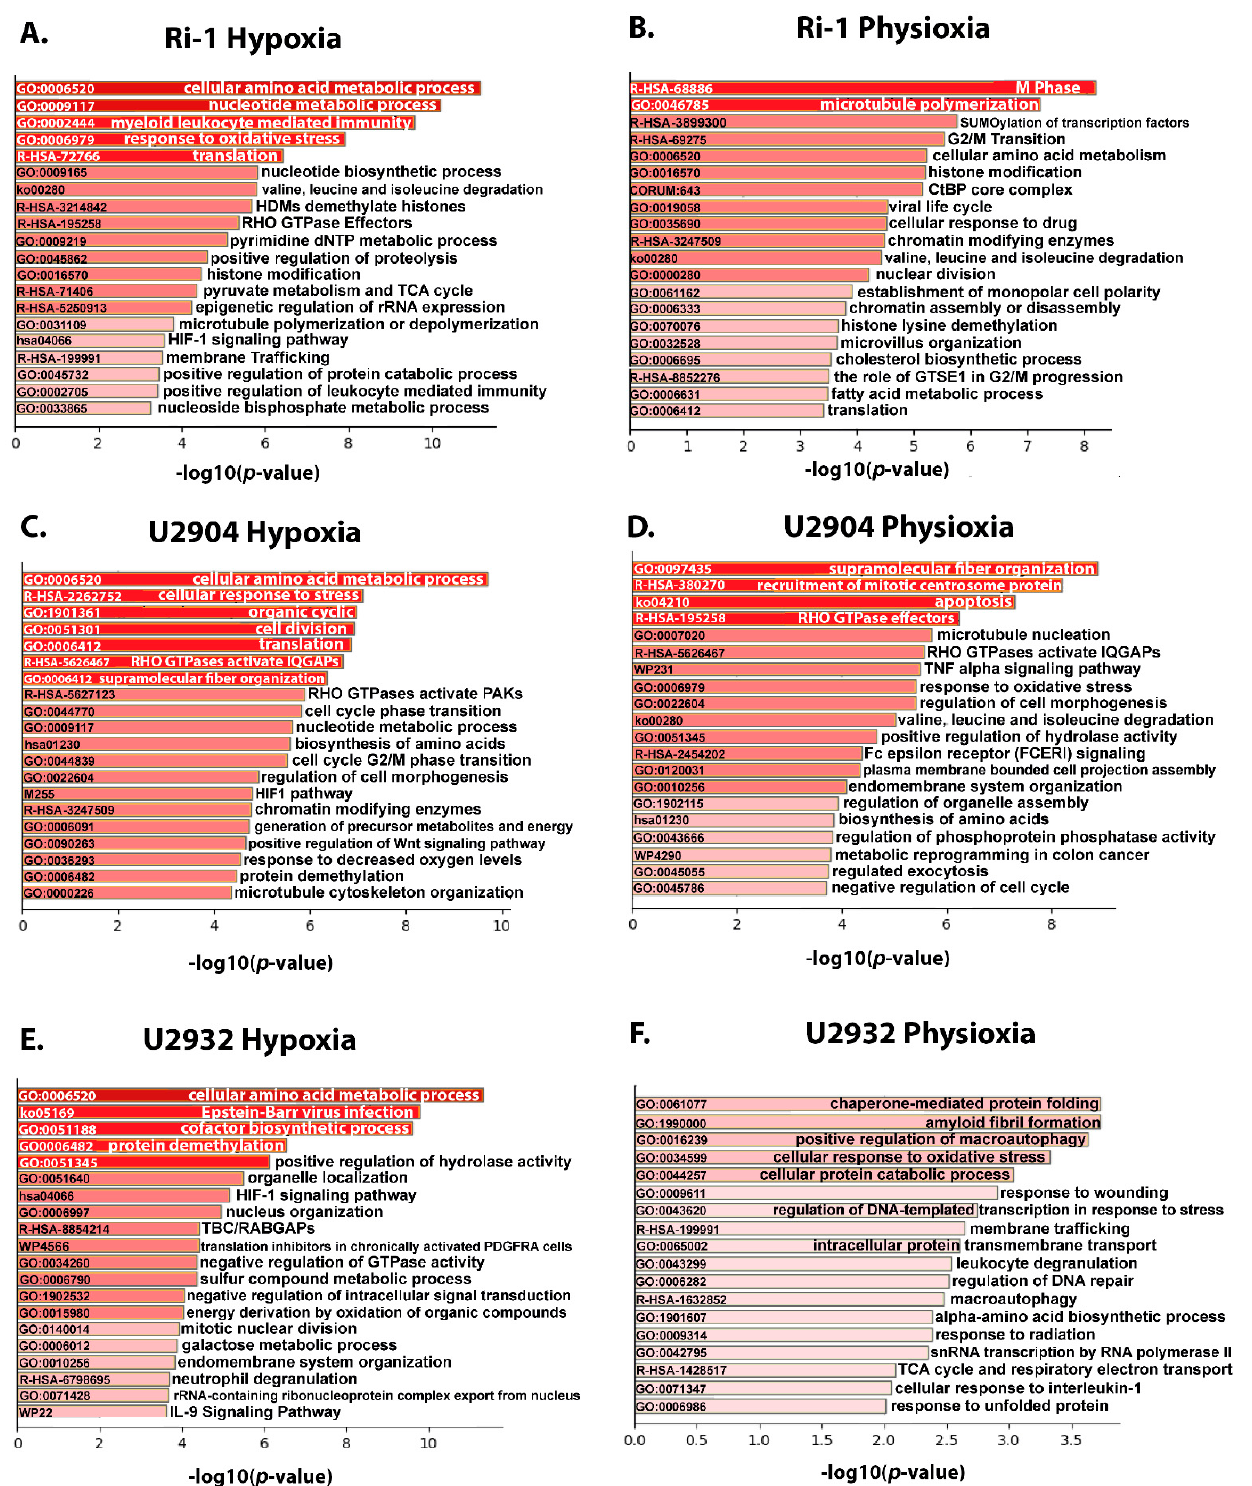
Figure 5. Enrichment analysis of upregulated proteins in hypoxia (1% of O 2 ) and physioxia (5% of O 2 ) in DLBCL cell lines using the Metascape database. The top 20 clusters with their representative enriched terms (one per cluster) are presented for each experimental condition. ( A ) The enrichment of 207 and 122 significantly upregulated proteins in hypoxia and ( B ) physioxia, respectively in Ri-1 cell line. ( C ) The enrichment of 230 and 150 significantly upregulated proteins in hypoxia and ( D ) physioxia, respectively in U2904 cell line. ( E ) The enrichment of 223 and 193 significantly upregulated proteins in hypoxia and ( F ) physioxia, respectively in U2932 cell line. The x-axis shows the significance, which is the value of − log10(P). Enriched terms are colored by p